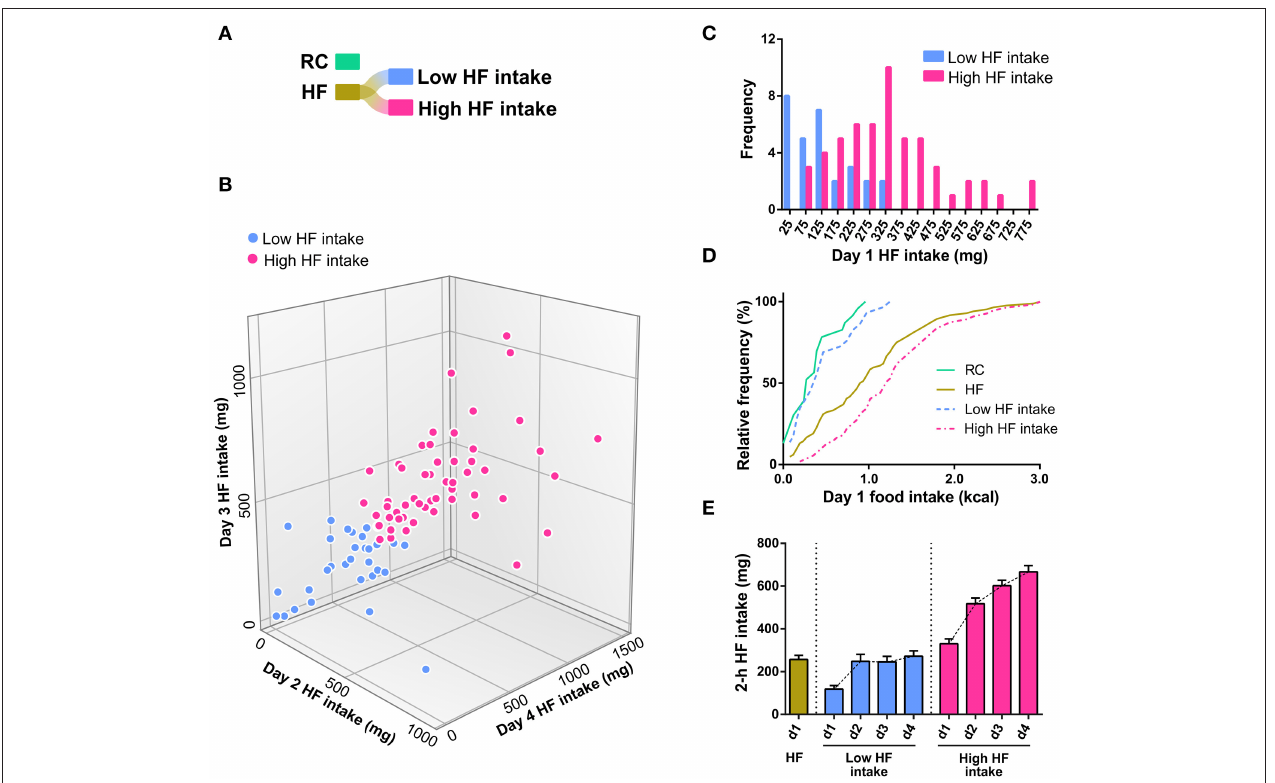
FIGURE 2 | (A) Graphical representation of the original dataset (RC and HF), and the new partitioning of HF after clustering. The coloring scheme is maintained throughout the figures. (B) 3D scatter plot of day 2, day 3, and day 4 HF intake classified into the two most dissimilar sets (labeled Low HF intake and High HF intake, and colored light blue and hot pink, respectively) after applying a clustering algorithm on these same days. The classification method used was an agglomerative hierarchical clustering algorithm implemented in KNIME, using the main two clusters obtained with a Euclidean metric for complete linkage distance. Note that day 1 HF intake was explicitly excluded from this analysis. (C) Histograms of the day 1 HF intake from the data shown in Figure 1 (B) , which has been disaggregated into two clusters of maximal dissimilarity (low HF intake and high HF intake) based on the HFD intake of the following 3 days. (D) Cumulative distributions of day 1 food intake of the RC, HF, Low HF intake and High HF intake groups. (E) Bar graph showing the day 1 HF intake in the HF group and HF intake observed over successive days in the Low HF intake and High HF intake